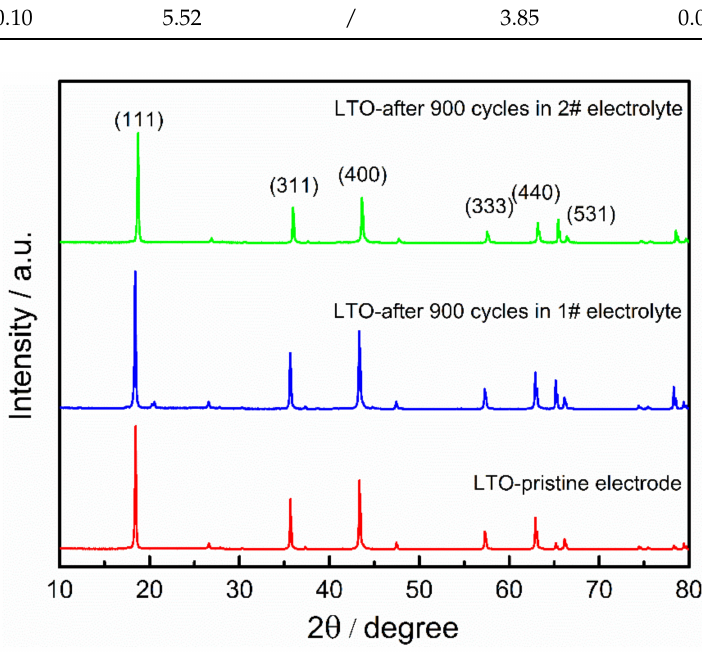
Figure 6. XRD pattern of LTO electrode before and after 900